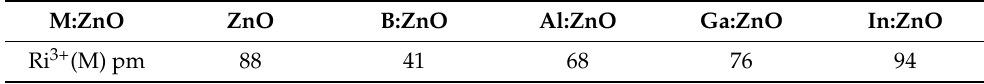
Table 4. The ionic radius of Zn 2+ and of its doping